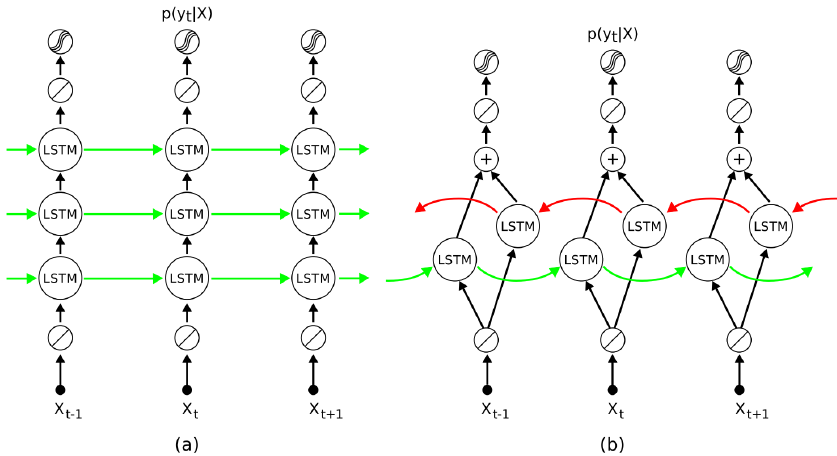
Figure 8. The structure of LSTM and bi-directional LSTM model [204]. ( a ). LSTM network hidden layers containing LSTM cells and a final softmax layer at the top. ( b ) bi-directional LSTM network with two parallel tracks in both future (green) and past (red)